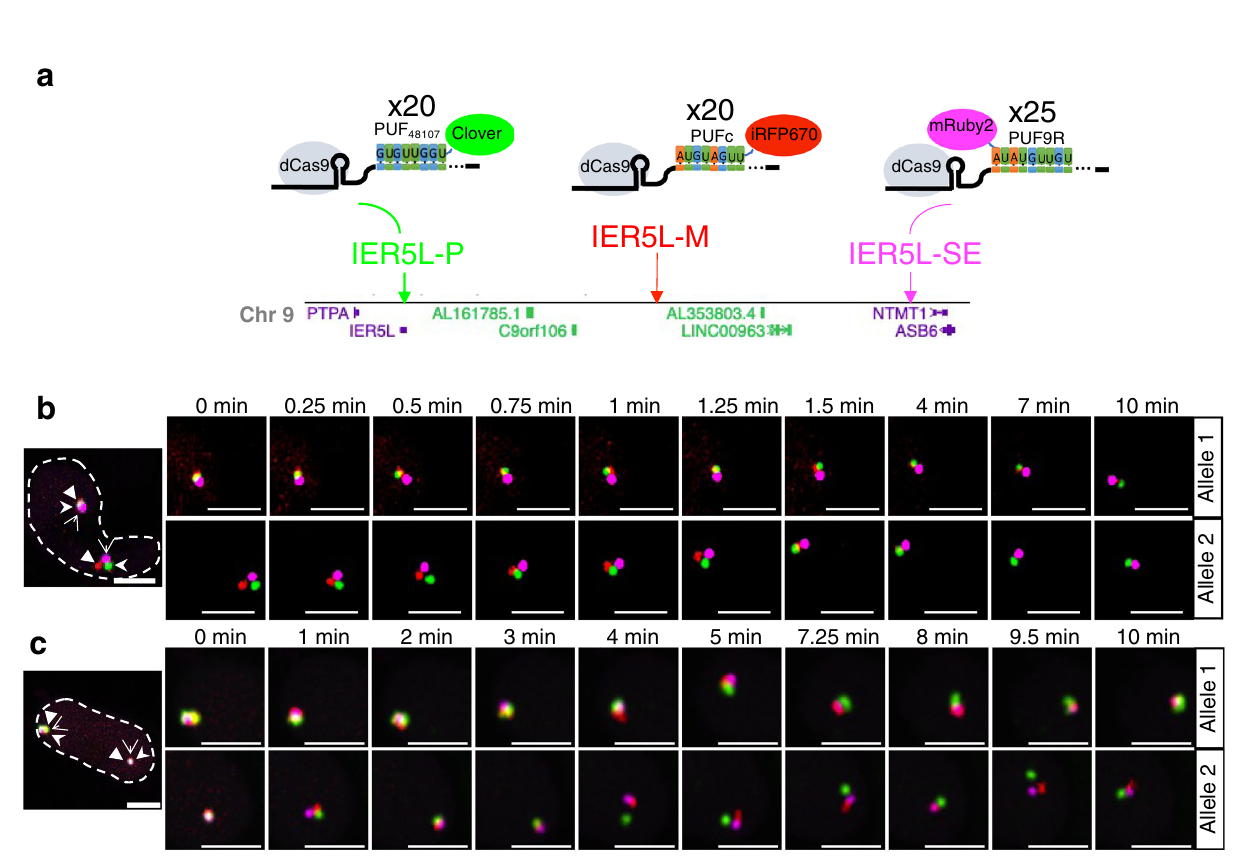
Fig. 5 Three-color three-point live-cell imaging of chromatin loops. a Casilio probes for visualizing chromatin interactions of IER5L promoter and its super-enhancer, with locus P (promoter) labeled by gRNA-20xPBS 48107 /Clover-PUF 48107 , locus M (mid-point) labeled by gRNA-20xPBSc/iRFP670-PUFc, and locus SE (super-enhancer) labeled by gRNA-25xPBS9R/PUF9R-mRuby2. Chr, chromosome. b , c Representative nuclei (nuclear boundaries outlined) and time-lapse images of IER5L- P-SE loop, with IER5L promoter, midpoint and super-enhancer labeled by Clover (green, stealth arrowhead), iRFP670 (red, triangle arrowhead), mRuby2 (magenta, open arrowhead), respectively, in HCT116/RAD21-mAID cells at the indicated time point. Scale bars 5 μ m. See Supplementary Videos 6, 7. See Supplementary Fig. 6 for distance plots of imaged nuclei ( n = 18 nuclei; 28 alleles). Experiment repeated 7